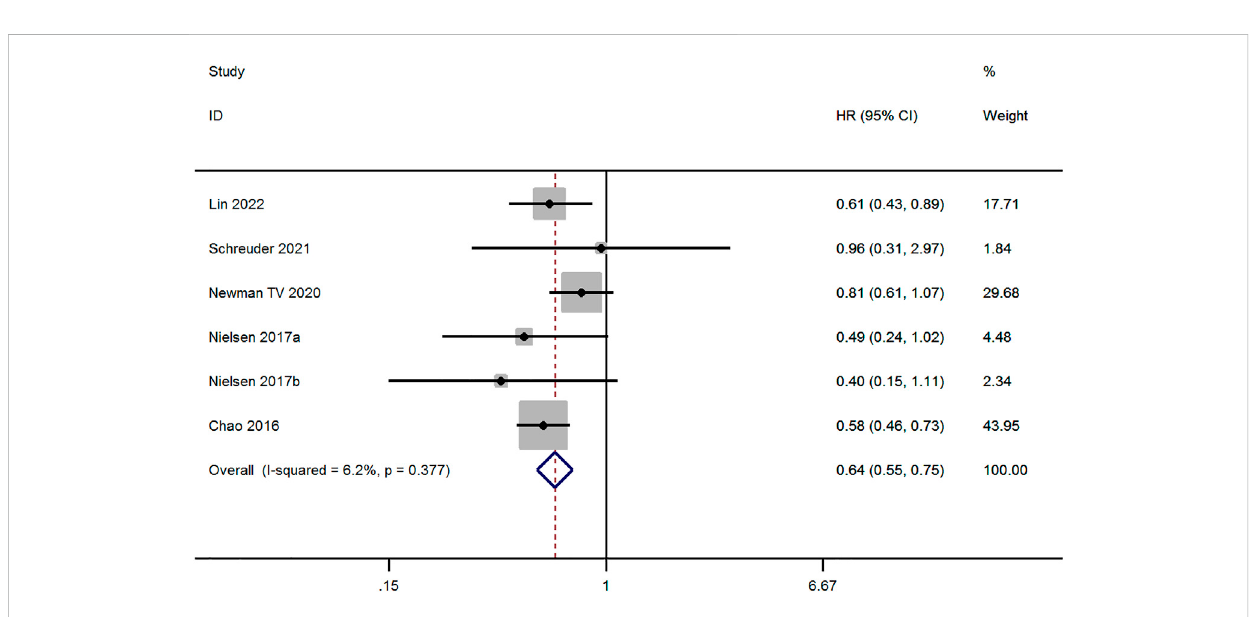
FIGURE 4 Meta-analysis of Ischemic Stroke/SE risk in OAC versus